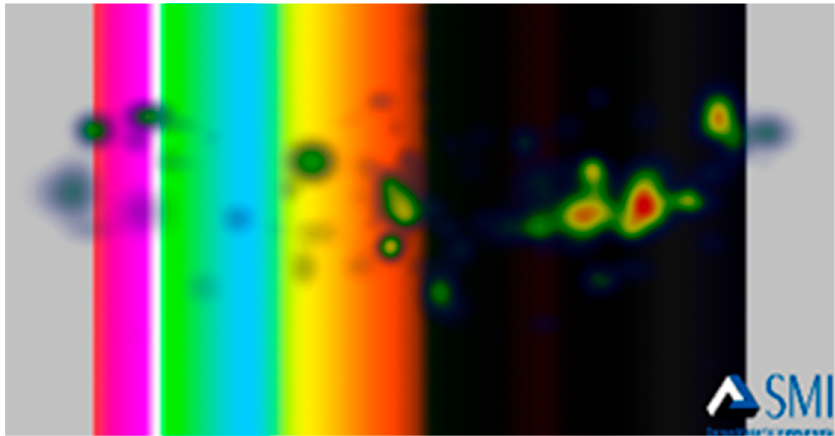
Figure 9. The heat map that demonstrates the eye-gaze patterns over the AOIs after displaying a negative stimulus.